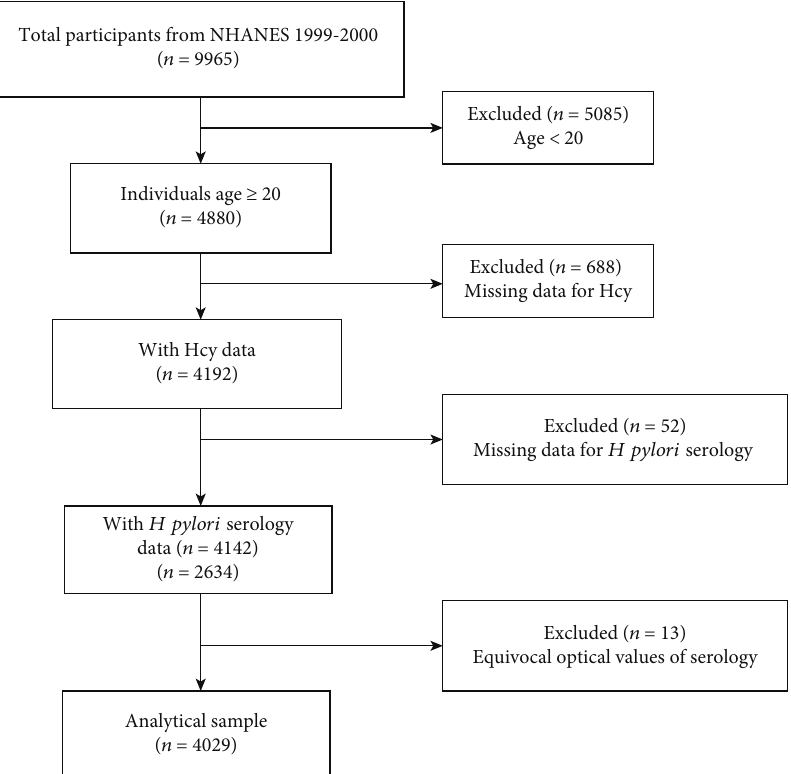
Figure 1: The sample selection fl ow